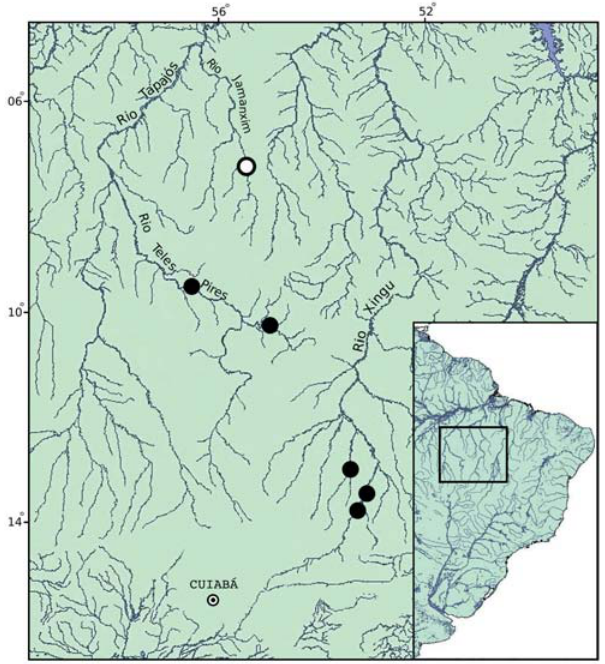
Fig. 13. Distribution of Leptodoras oyakawai in Tapajós and Xingu basins, central Brazil (type locality represented by open